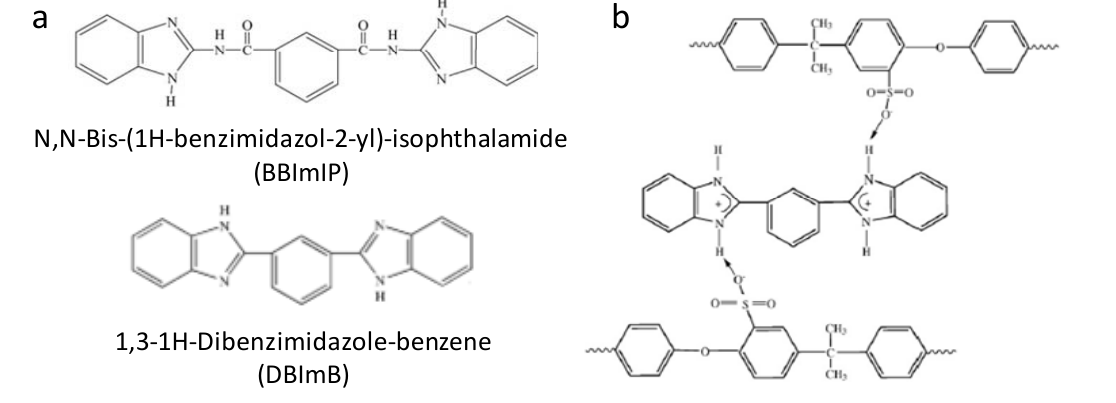
Figure 7. ( a ) Structure of BBImIP and DBImB and ( b ) illustration of the assistance of benzimidazole in the Grotthuss-type proton conduction mechanism in the blend membranes. (Reprinted with permission from [54]. Copyright 2008